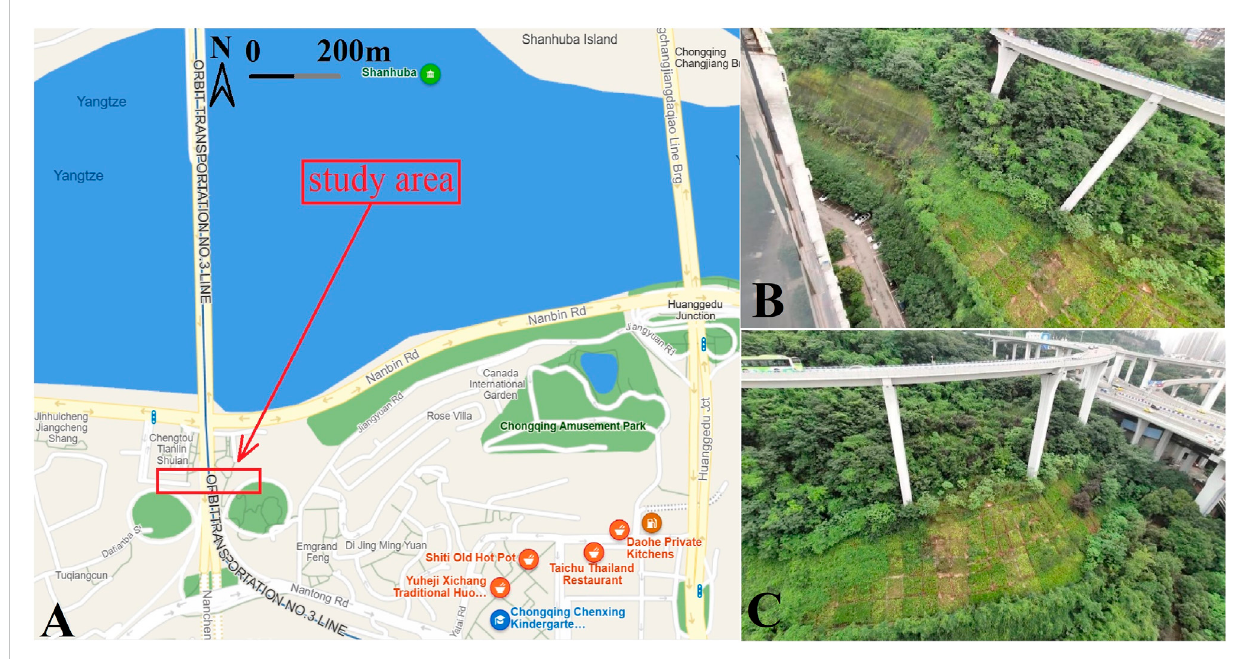
FIGURE 1 Location of the study area. (A) Traf fi c location of the study area. (B,C) Field situation of the Sujiaba overpass slope.